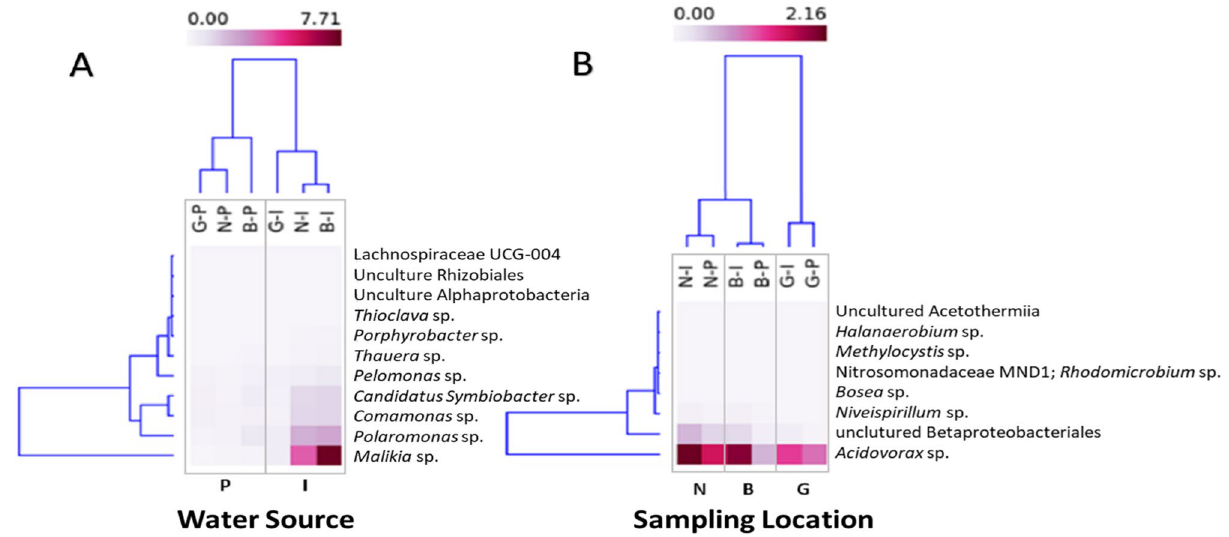
Figure 4. Heatmaps based on Person-multiple correlation analysis among the identified bacterial species. Two heatmaps, one was able to discriminate the I- source samples from the P-source samples and includes 11 species ( A ), and the other discriminates the N, B, and G locations regardless of the water source and includes nine species ( B